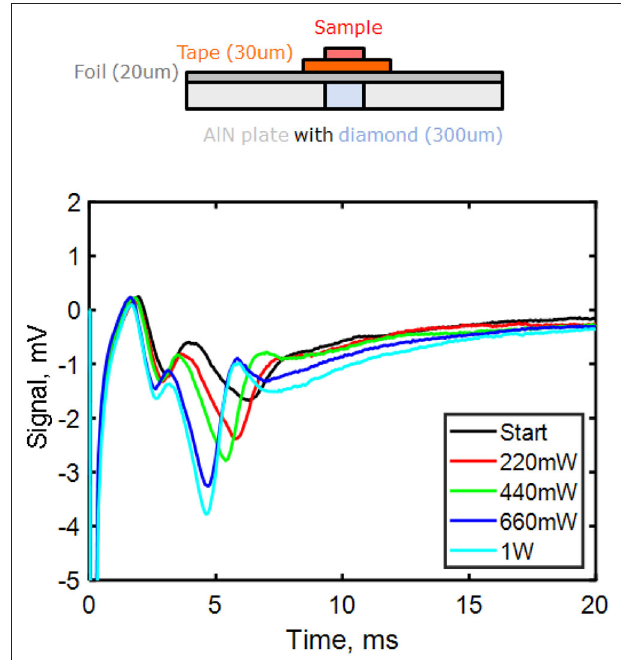
FIGURE 4 | Change in mouse brain slice hippocampal field potential in the CA1 region at specific laser powers during laser ramp up (at 0.01 W every 20 s). The signal was recorded using a Pt/Ir electrical probe inserted into the region. Laser power was ramped to a maximum of 1 W, with the slice thermally isolated from the diamond by a layer of 20 µ m thickness aluminum foil heatsunk into the surrounding solution and 30 µ m thickness Kapton tape. The diamond is within the center of a 2 2 cm AlN ×